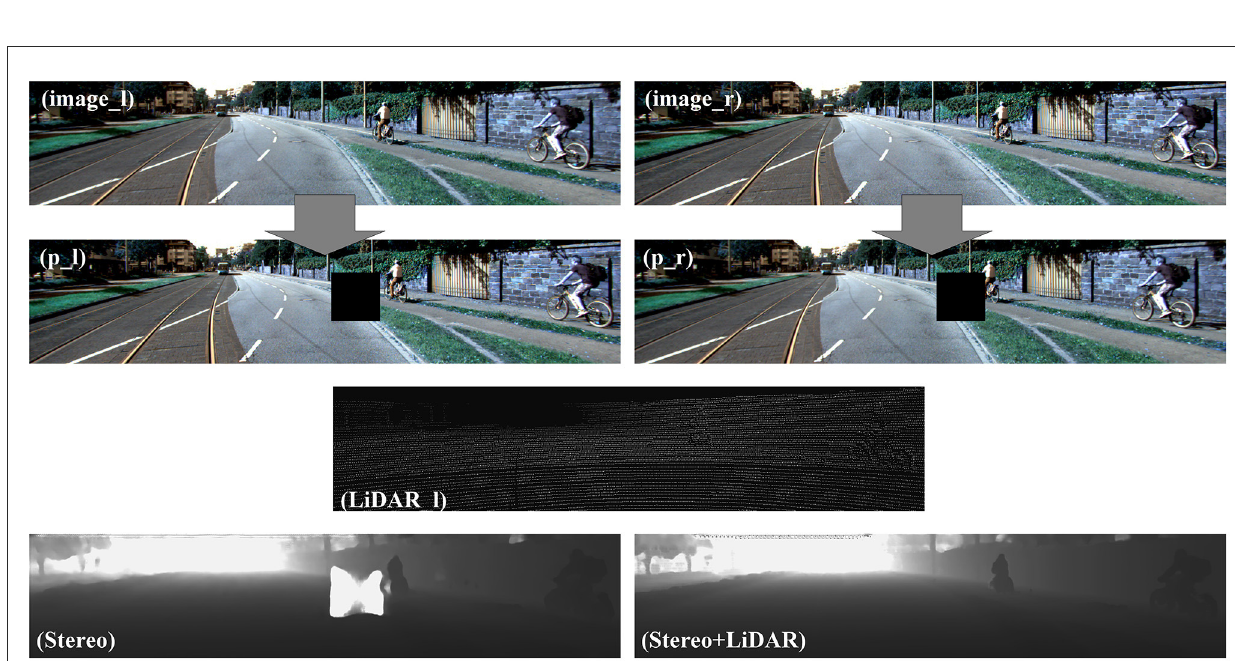
FIGURE6 Results of our network using problem data. p_l and p_r were obtained after the left and right images were pre-processed. Stereo is the depth image obtained by stereo matching. Stereo + LiDAR is the depth image obtained by our network based on